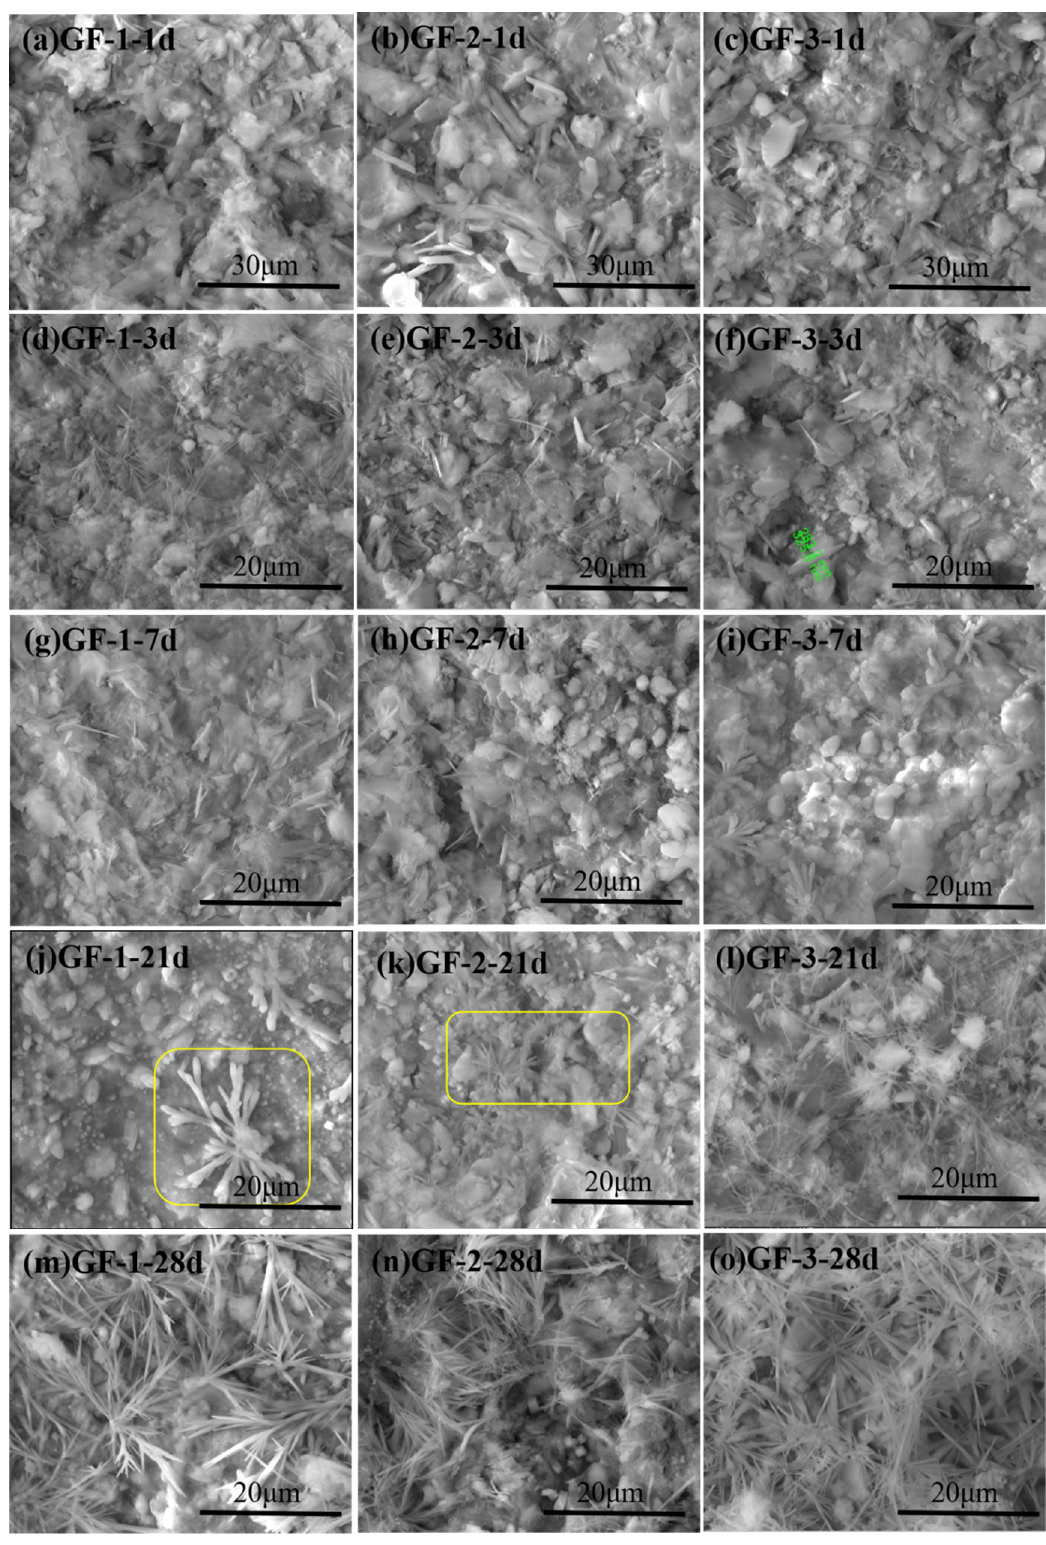
Figure 5. The ESEM images of the BBSC pastes after curing for ( a – c ) 1 d, ( d – f ) 3 d, ( g – i ) 7 d, ( j – l ) 21 d, and ( m – o ) 28 d. and ( m – o ) 28